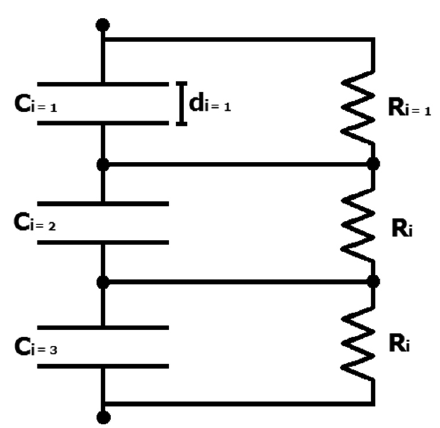
Figure 10. Schematic electrical circuit that represents the multi- layer composite (wood-geotextile